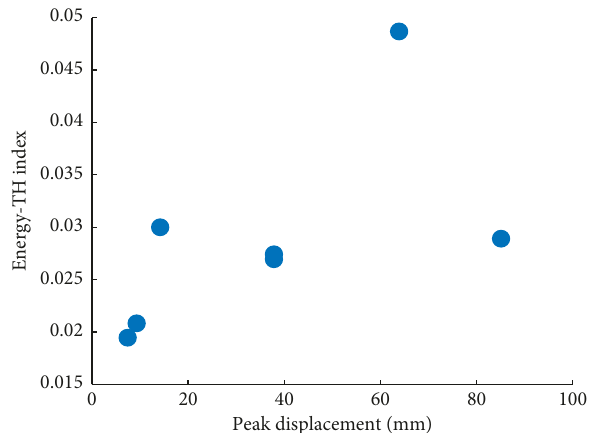
Figure 29: Energy-TH index of test cases under displacement excitation.